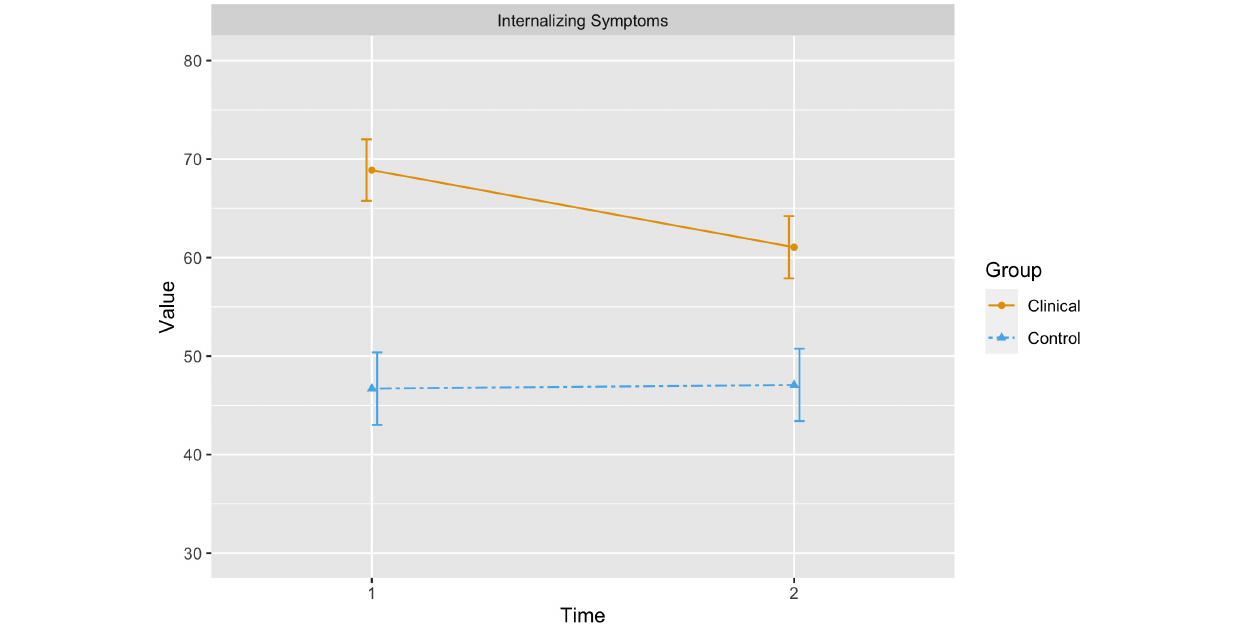
FIGURE 1 | The orange (solid) line represents the change in estimated marginal means for internalizing symptoms in the children with internalizing difficulties from time 1 to time 2, while the blue (dashed) line represents changes in internalizing symptoms in the control group. The bars represent 95 percent confidence